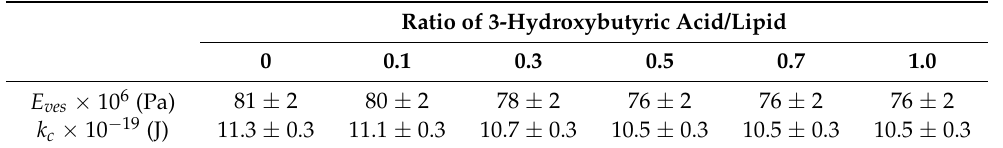
Table 2. Mechanical moduli of the vesicle for the ratio of 3-hydroxybutyric acid/lipid, E ves : Young’s modulus and k c : bending